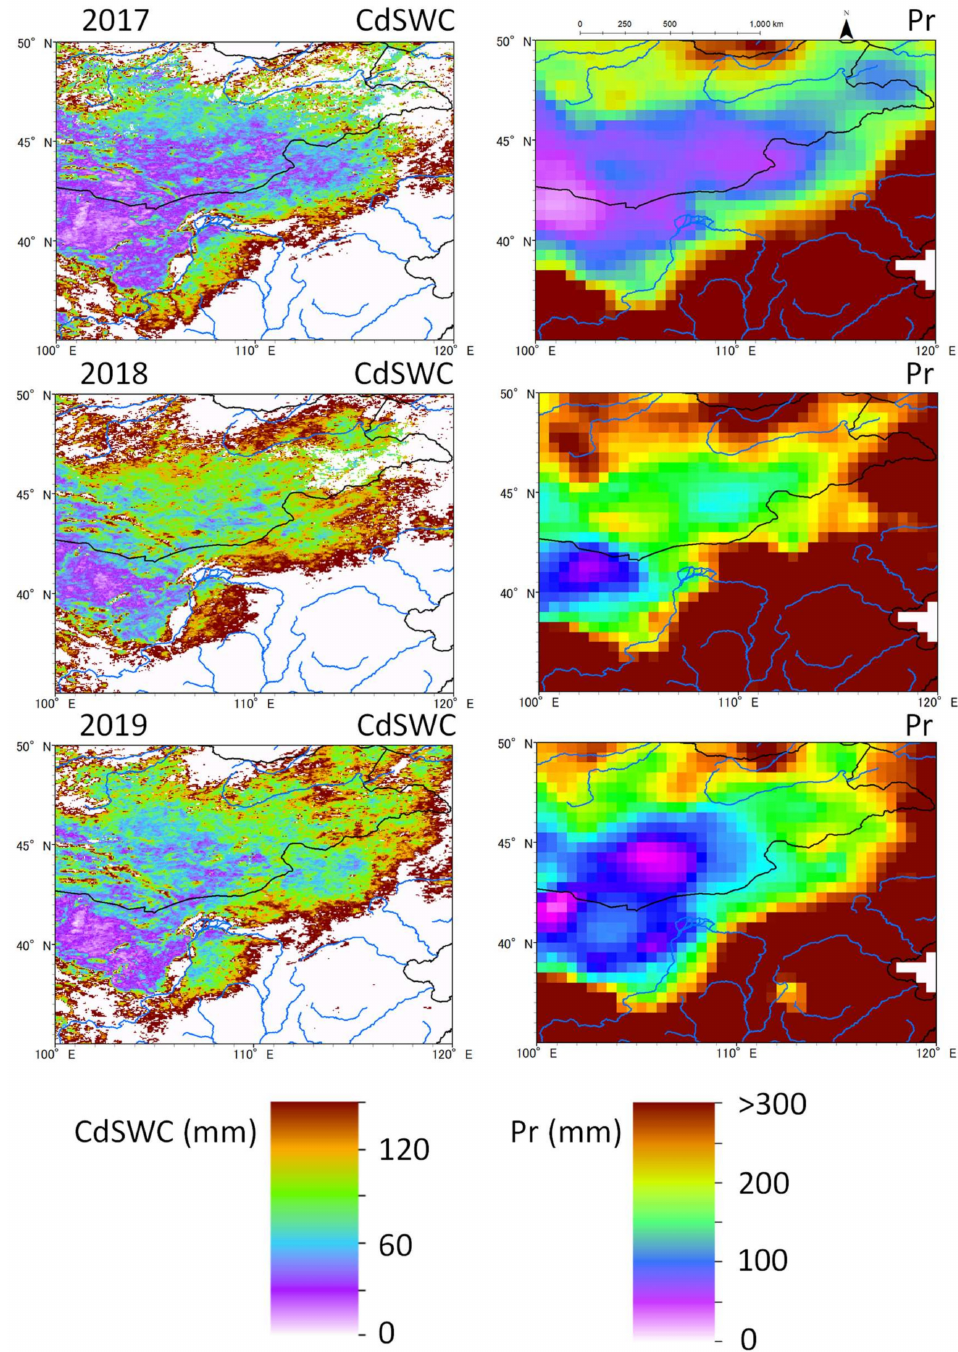
Figure 10. Spatial distribution of the CdSWC (mm) calculated from the CRSbAI (monthly) and precipitation (Pr, mm) from April to August 2017 to 2019, using the CPC Global Unified Precipitation data. White areas indicate where the CRSbAI > 150 mm (therefore, data not